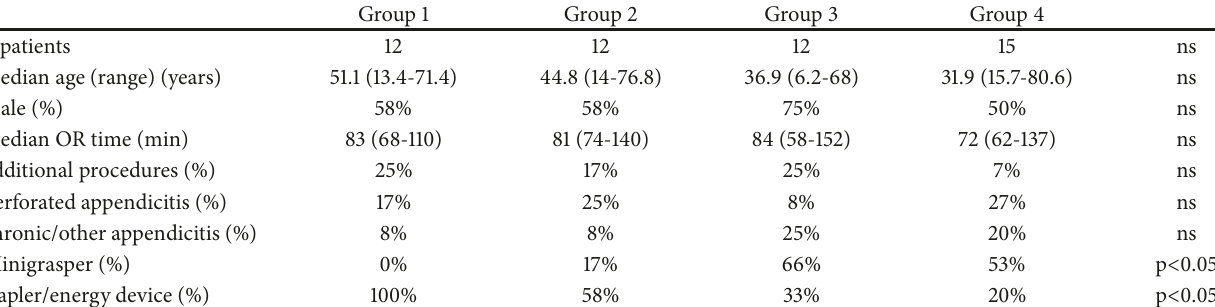
Table 1: Demographic and clinical